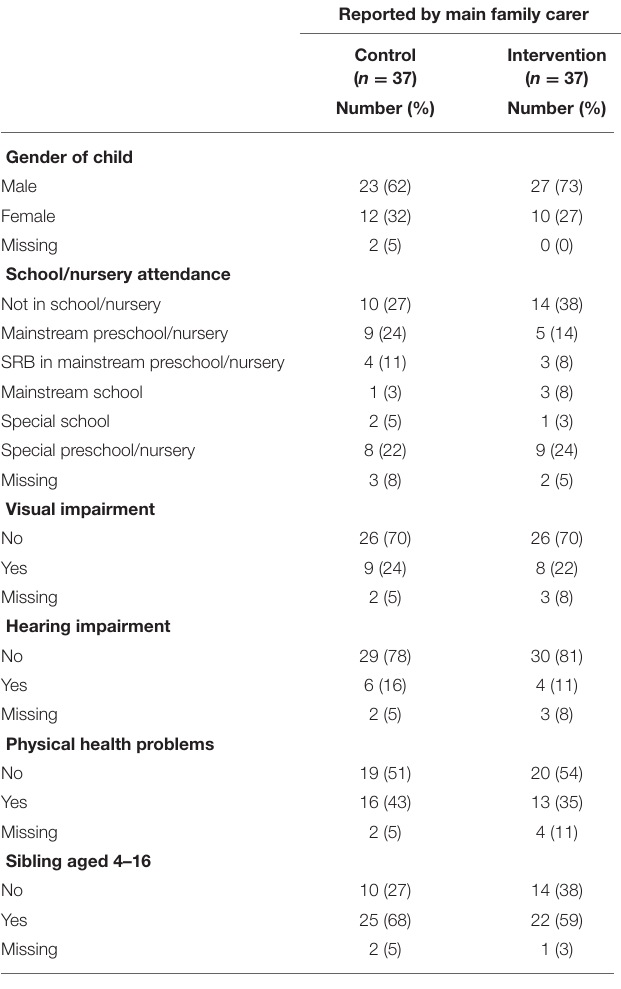
TABLE 4 | Baseline characteristics of child with